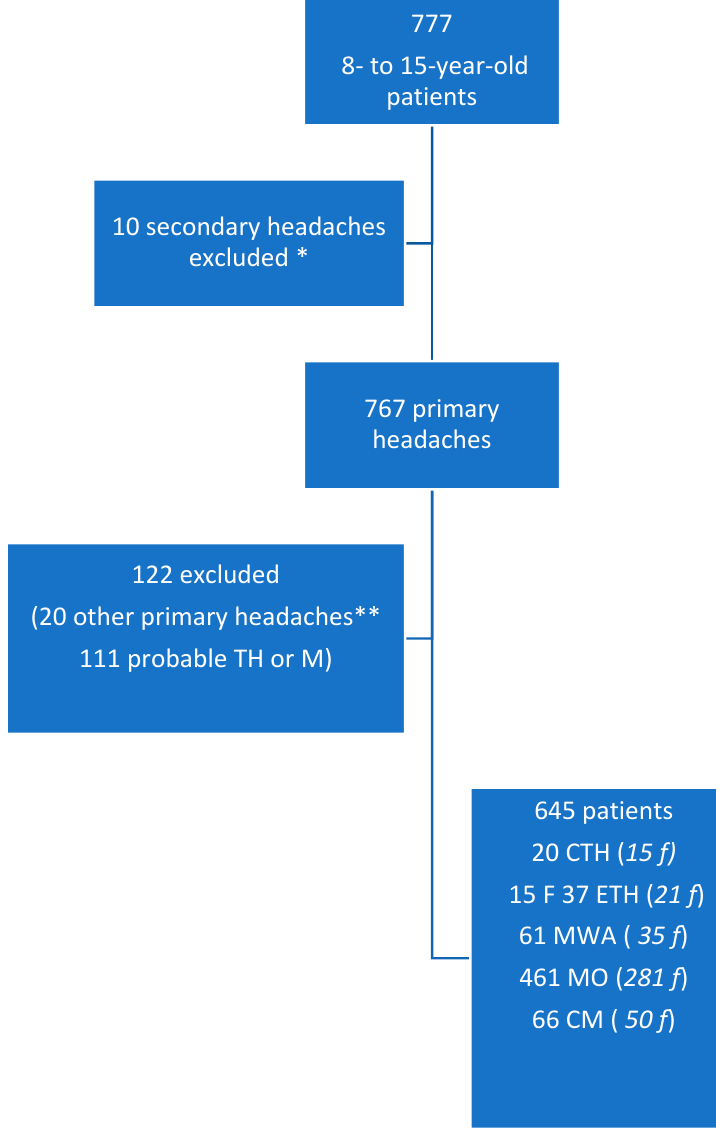
Figure 1. Flow chart depicting patient inclusion criteria. TH: tension-type headache; M: migraine; ETH: episodic tension-type headache; CTH: chronic tension-type headache; MWA: migraine with aura; MO: migraine without aura; CM: chronic migraine; * post-traumatic, cranial hyper- and hypotension, somatoform disease, cranial neuralgia; ** 1 nummular headache, 2 primary exercise headaches, 11 primary stabbing headaches, 2 benign paroxysmal vertigo episodes, 1 abdominal migraine, 2 cyclical vomiting syndrome, 2 new daily persistent headaches. Table 1. Prevalence of osmophobia in the cohort of primary headaches. ETH: episodic tension-type headache; CTH: chronic tension-type headache; MWA: migraine with aura; MO: migraine without aura; CM: chronic migraine. Patients with ETH presented with a lower prevalence of osmophobia (chi-squared p < 0.001).